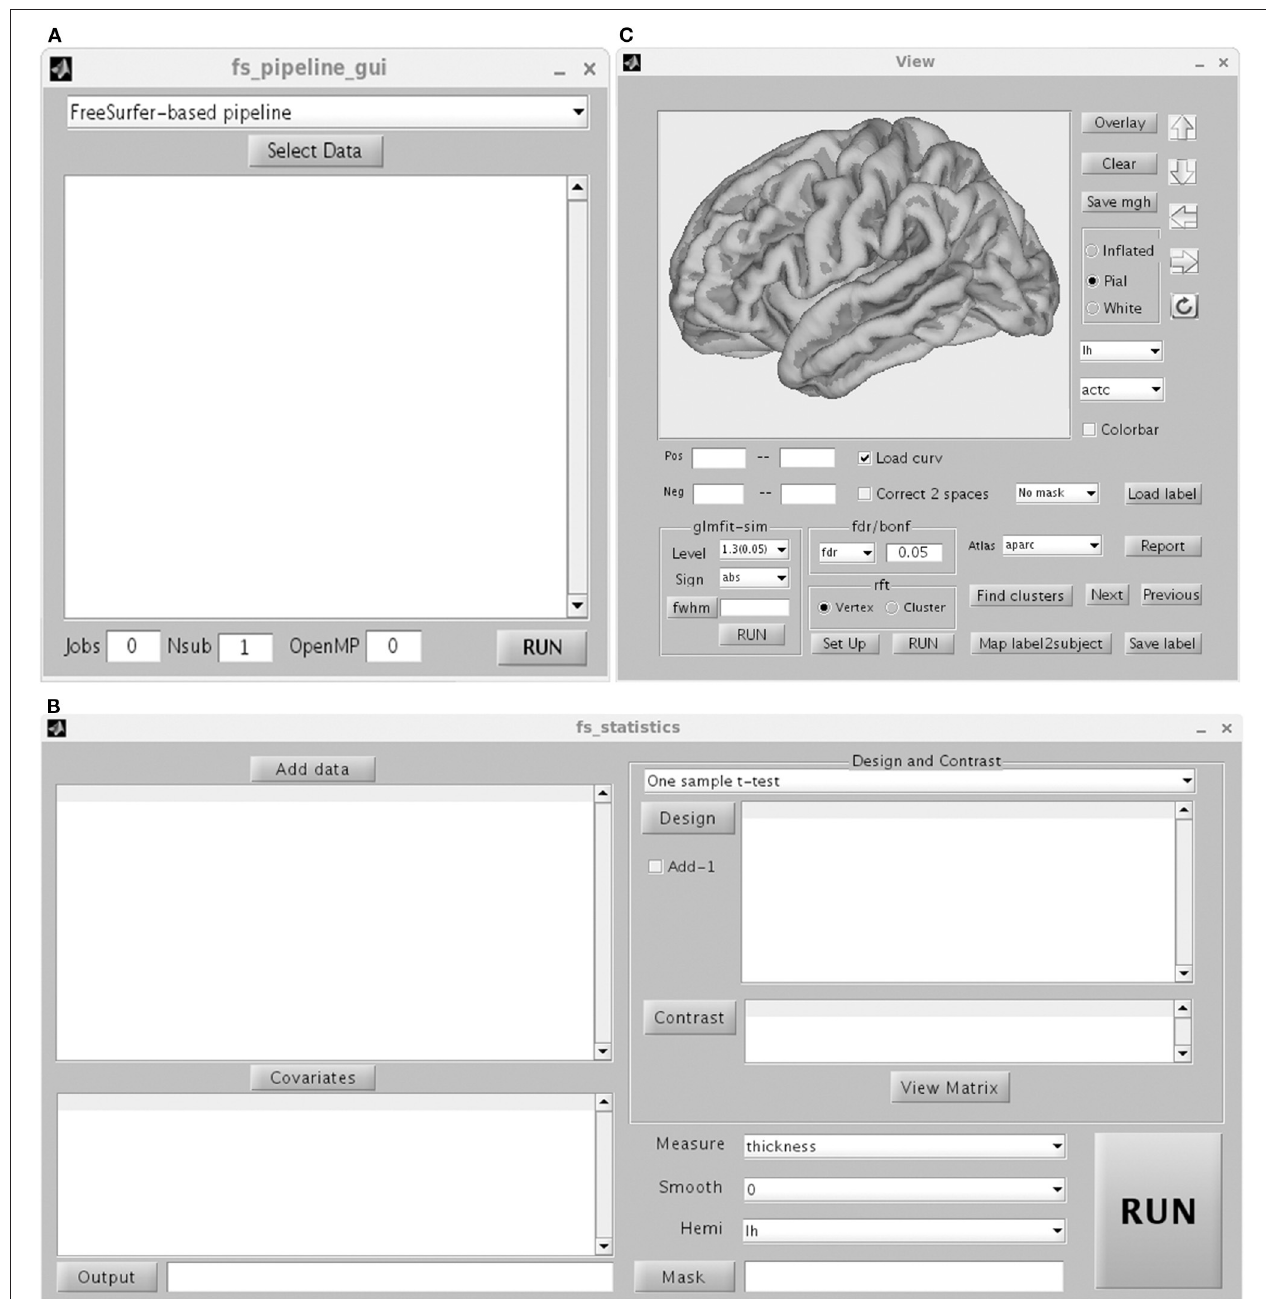
FIGURE 3 | Graphical user interface of Pipeline (A) including FreeSurfer-based pipeline, ANTs-based pipeline and CAT-based pipeline, statistics (B) and view (C) .